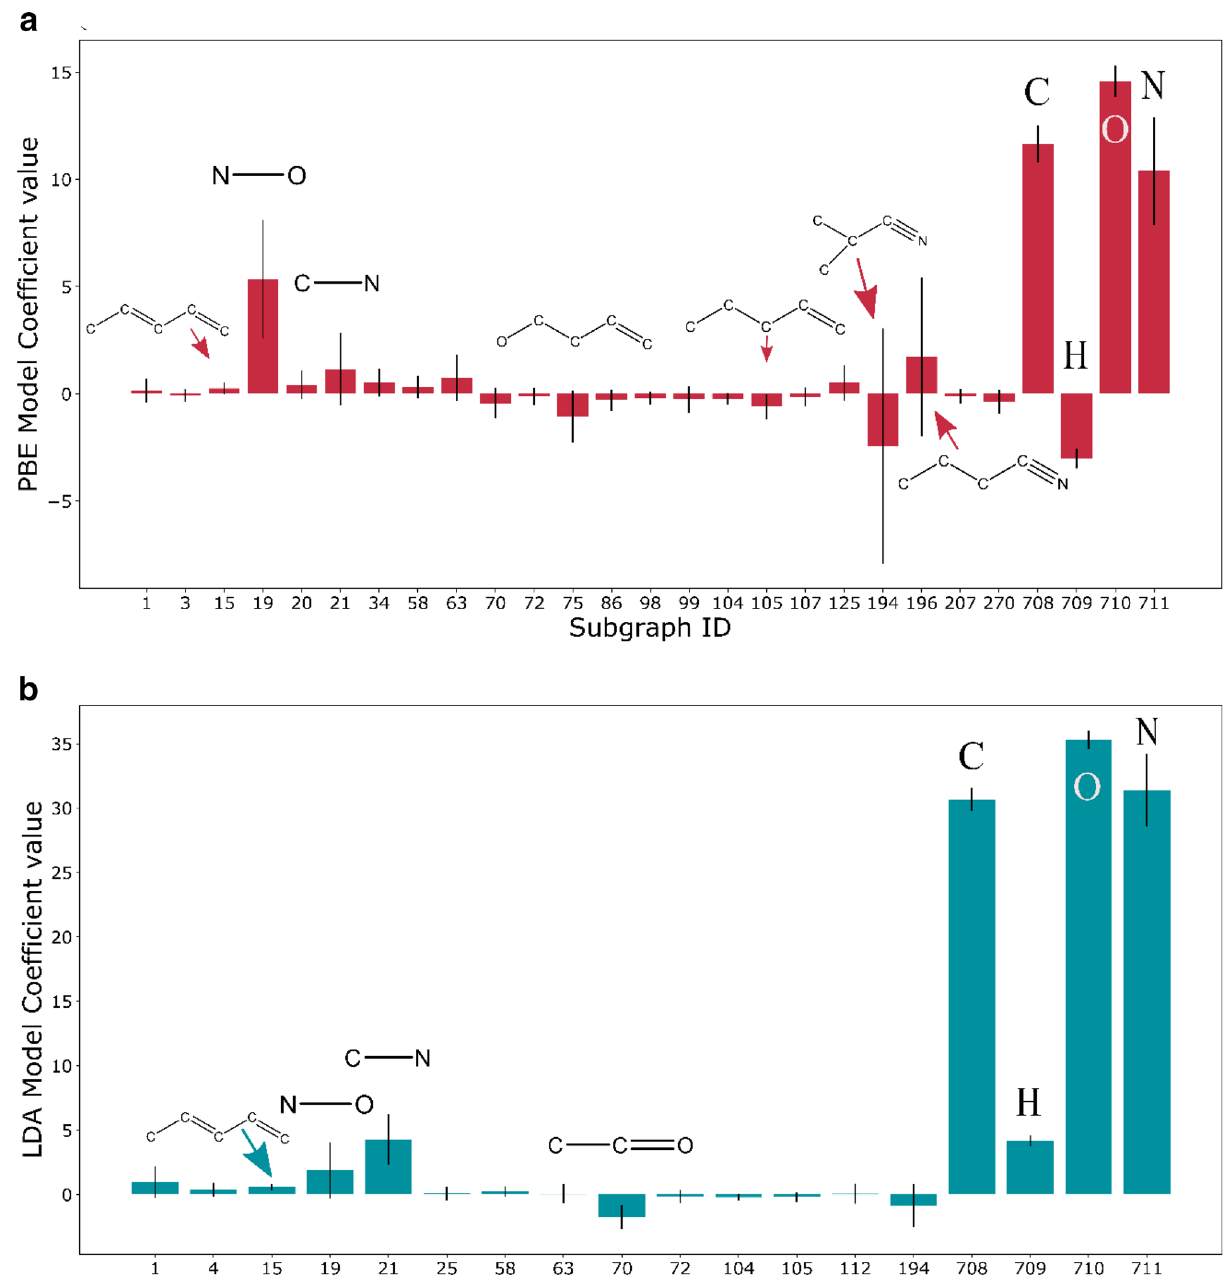
Figure 3. Coefficients of the key groups identified by the ( a ) PBE and ( b ) LDA error model. A list of all groups has been made available with the Supplementary Materials and their coefficients can be found on the GitHub